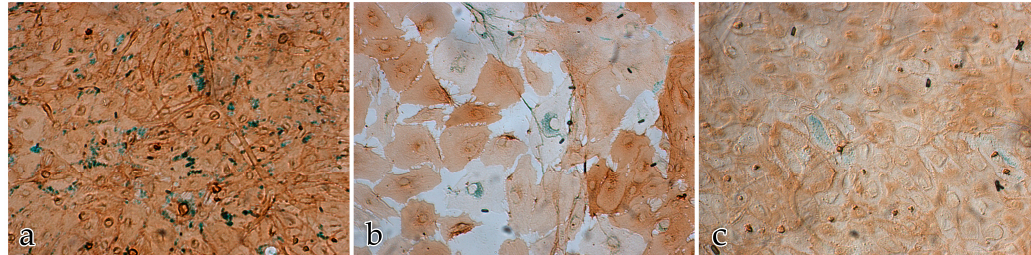
Figure 9. Immunolocalization of the ECM proteins (green) collagen III, fibronectin, and laminin in EC monocultures after 14 days. The ECs are immunolabeled with anti-CD31 (brown staining): ( a ) immunolocalization of collagen III; ( b ) immunolocalization of fibronectin; ( c ) immunolocalization of laminin. Magnification ×20.